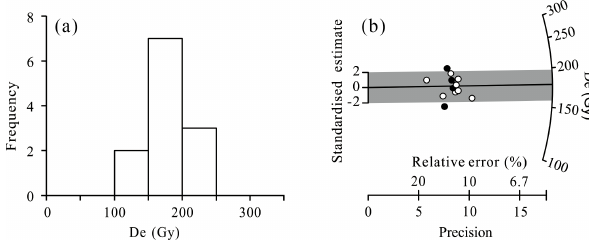
Figure 3. D e distribution histogram (a) and radial plot (b) showing the distribution of D e results for the fine grains. The shaded region represents 2 σ width of the distribution. The filled symbol represents the aliquots that were excluded in the final age